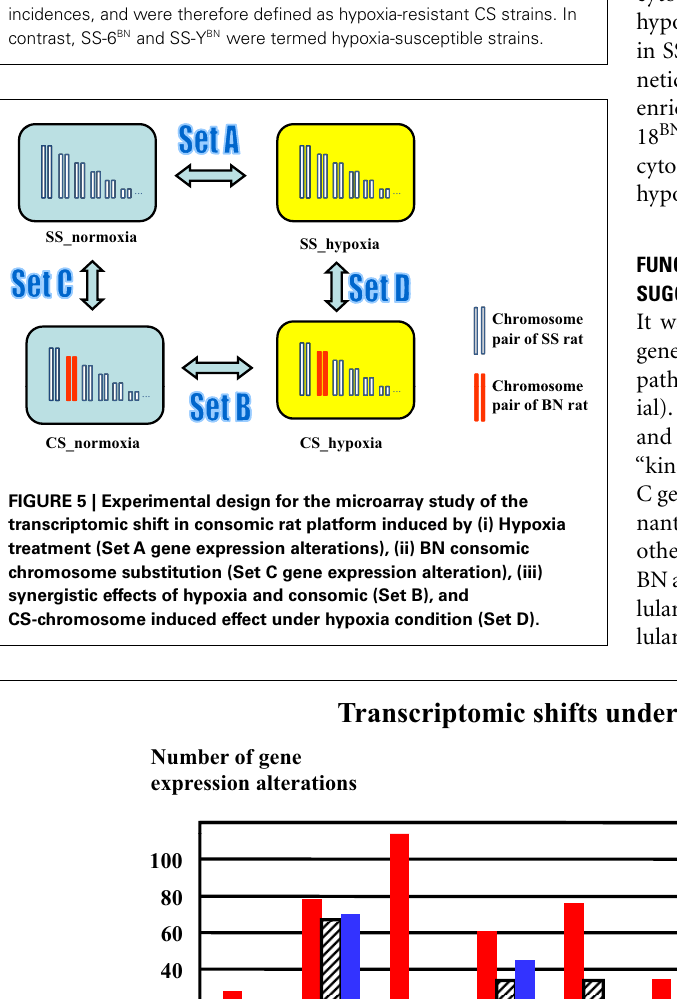
FIGURE 6 | Hypoxia-induced divergent transcriptomic shifts in different strains. The biggest transcriptomic shifts (most profound gene expression alterations) were observed for SS-2 BN and SS-Y BN , whereas the smallest